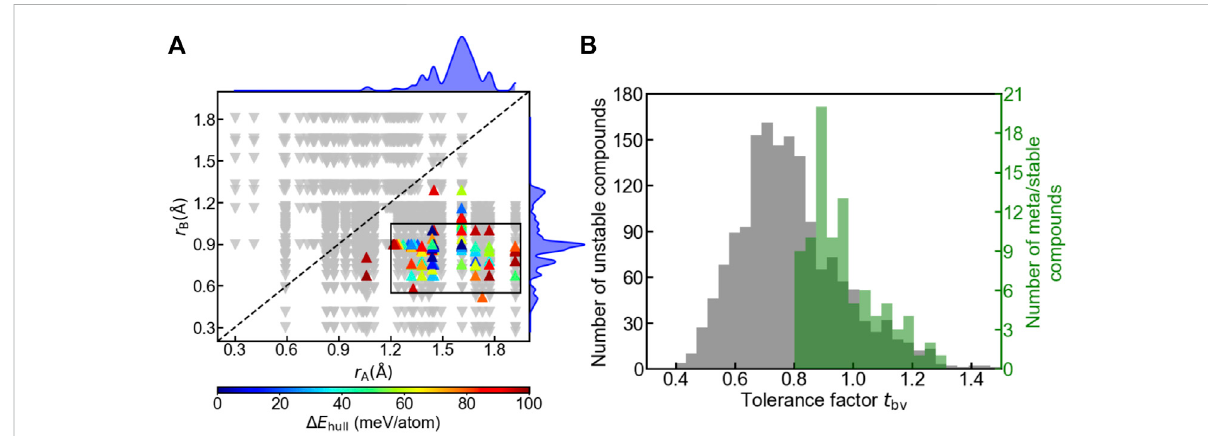
FIGURE 6 (A) Structure map of A 2 BH 1+ x O 3- x ( x = 0, 1, 2) oxyhydrides with the Shannon ionic radius of ion at A site ( r A ) vs that at B site ( r B ). Up-pointing triangles indicate meta/stable oxyhydrides ( Δ E hull ≤ 100 meV/atom), which are colored as a function of Δ E hull . Those meta/stable compounds are clustered within the rectangular box (0.55 Å < r B < 1.05 Å, 1.20 Å < r A < 1.95 Å). Down-pointing triangles indicate unstable oxyhydrides ( Δ E hull > 100 meV/atom). The upper and right curves represent the distribution of meta/stable oxyhydrides as a function of r A and r B , respectively. (B) Distribution of the oxyhydrides as a function of the tolerance factor t bv , where the left and right y -axis refer to the number of unstable and meta/ stable oxyhydrides,